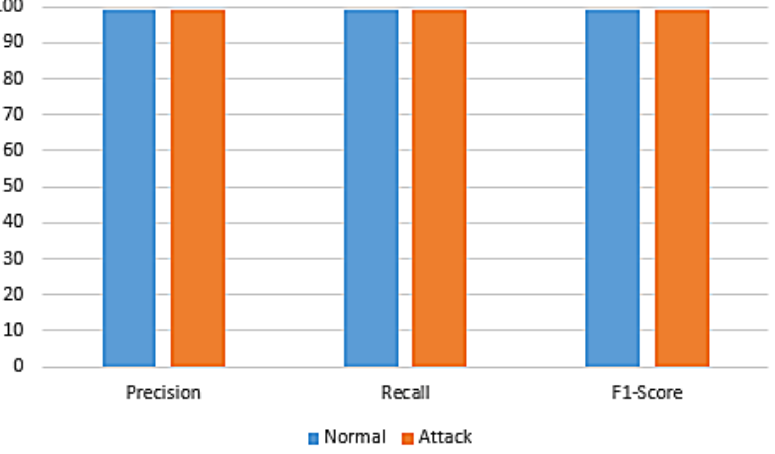
Figure 18. Random forest binary class classification report.